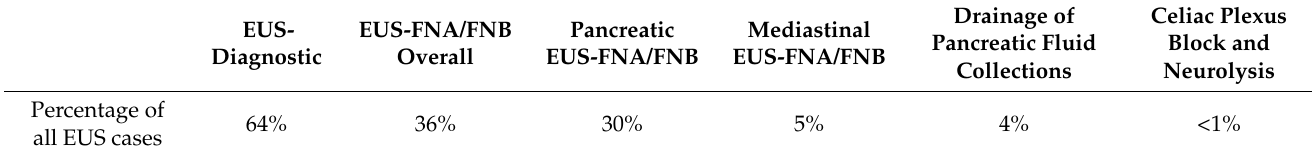
Table 1. Diagnostic and interventional EUS procedures performed during the two